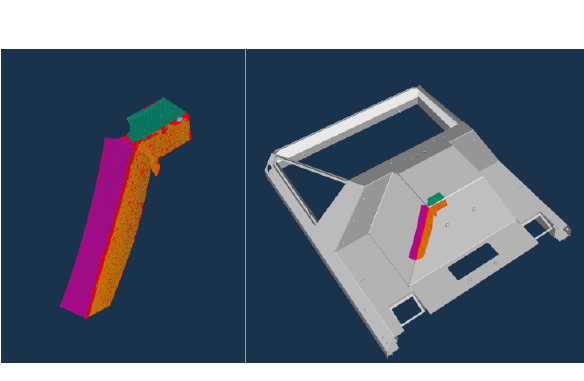
Figure 10: Segmented point cloud in precise localization, obtained by scanning motions and fitted into 3D-model